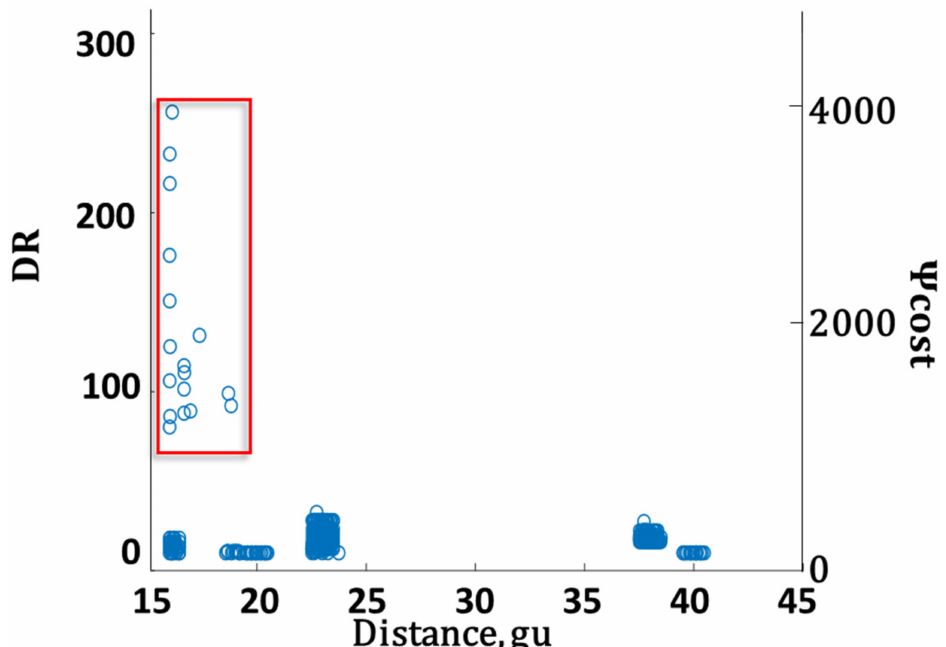
Figure 4. The sensors’ DR (left axis) and cost (right axis) distribution for different distances for all feasible solutions obtained when using a high-end sensor array. The red rectangle frames the exceptionally accurate feasible solutions that result from using detectors with a very high